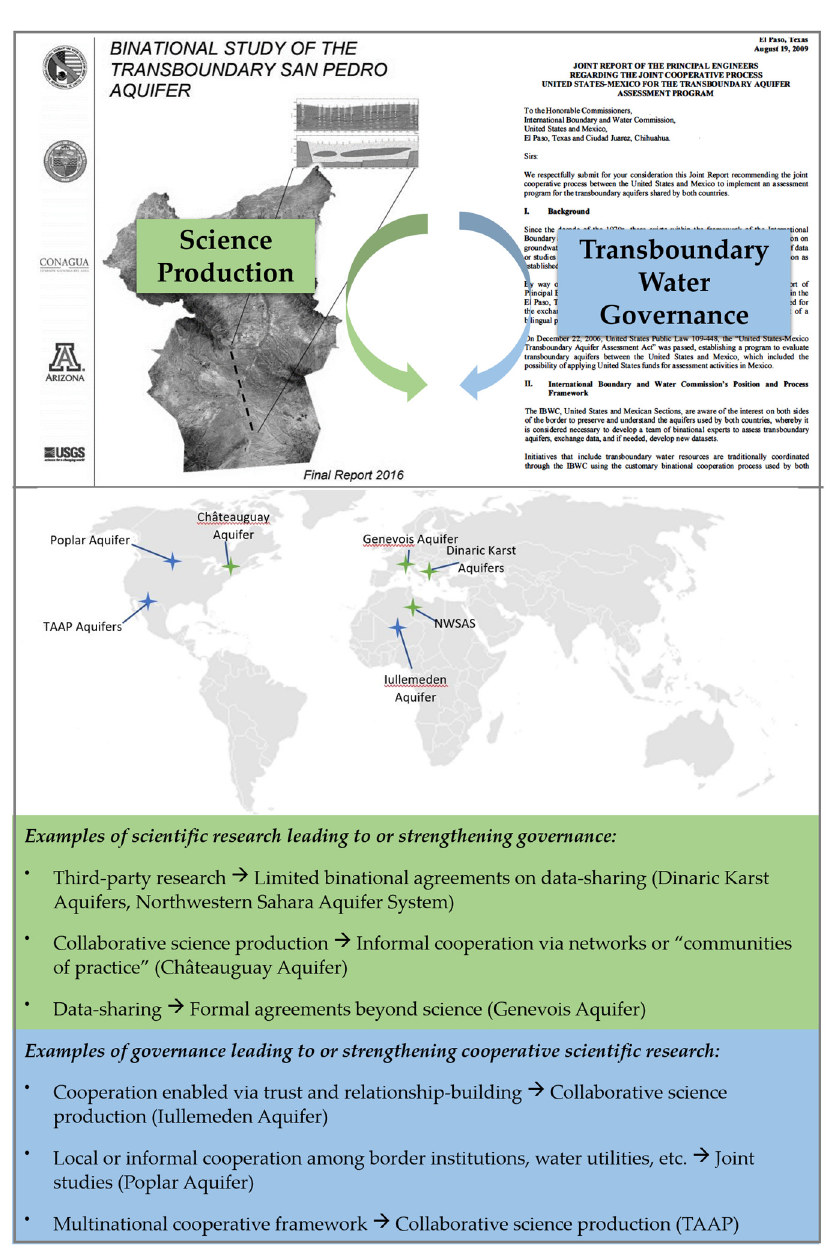
Figure 2. Bidirectionality of science production and transboundary water governance. Case study examples aside from the TAAP are from [69].